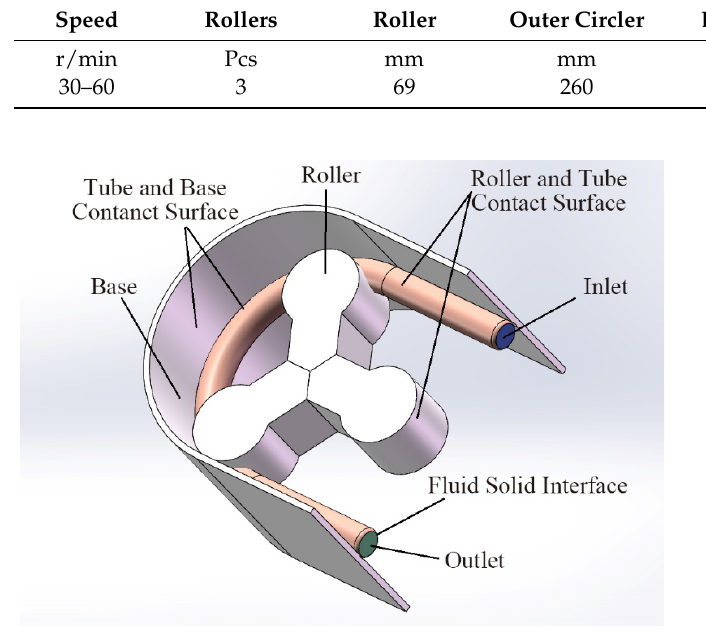
Figure 1. Three-dimensional finite element schematic diagram.